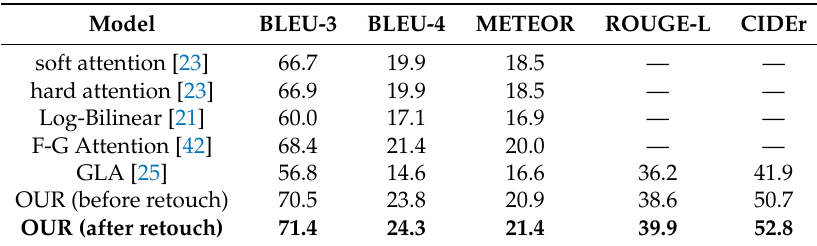
Table 8. Evaluation results of our method on the Flickr30K